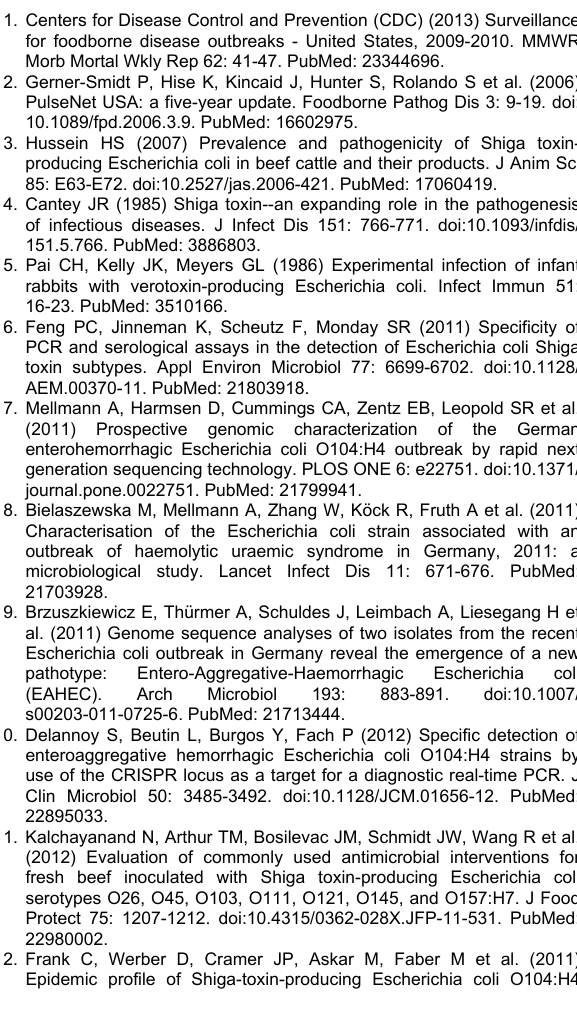
Figure S4. The effect of chicken extract on colony size. Adding 50 µL of chicken breast extract slows the growth of the Stx2f-expressing strain and the FSIS EC465-97 fluorescent control strain. The colonies on these plates are derived from the same two strain mixture as in Figure